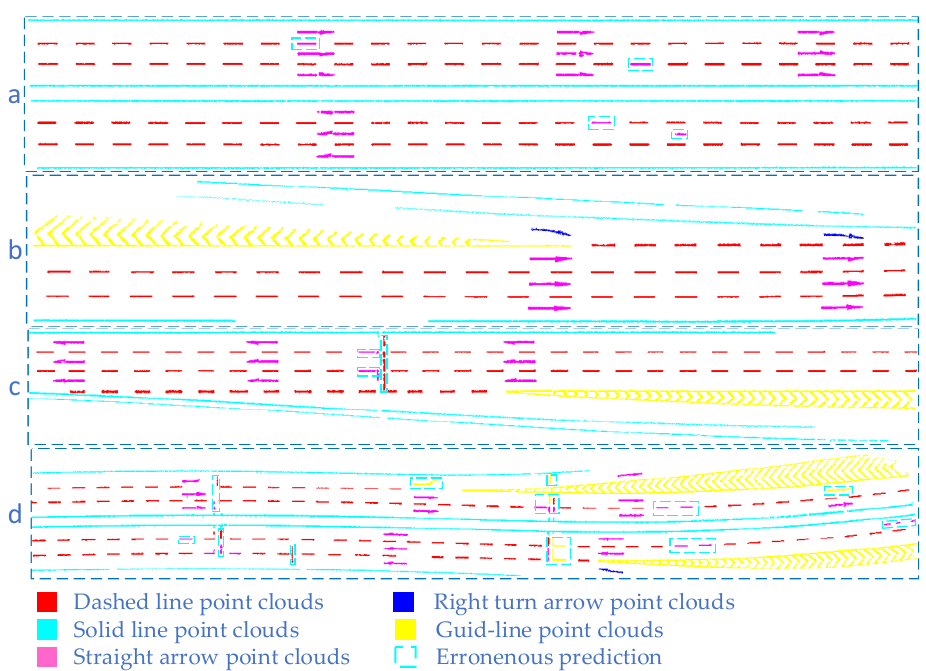
Figure 17. The result of semantic recognition of road markings. ( a ) The result of semantic recogni- tion of Figure 16a; ( b ) The result of semantic recognition of Figure 16b; ( c ) The result of semantic recognition of Figure 16c; ( d ) The result of semantic recognition of Figure 16d.